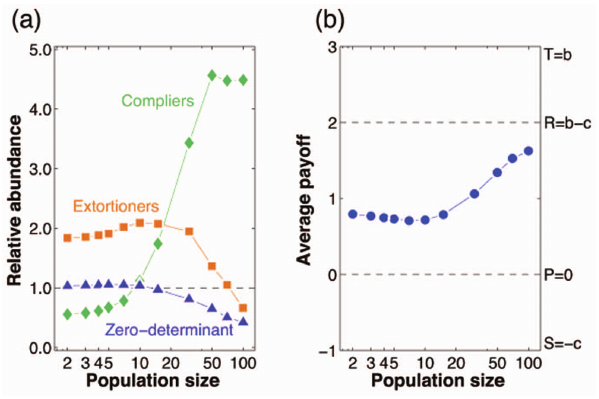
Figure 6. Statistics for the stochastic dynamics on the space of all memory-one strategies. Instead of taking the enforceable pairs ( l , s ) as the evolving traits, we consider the adaptive dynamics on the space of memory-one strategies p ~ ( p R , p S , p T , p P ) , see also [23,25]. (a) To assess the impact of zero-determinant strategies, extortioners, and compliers, we record how often the evolving population is in a d - neighborhood of these strategy sets, and compare this to their expected abundance in a neutral process. A given strategy set is thus favored by selection if its relative abundance exceeds one. Our simulations indicate that in small populations extortioners are favored by selection, whereas in large populations compliers are favored. (b) As a consequence, average payoffs increase with population size. Simulations are run for a sequence of 10 6 mutants. We assume that mutant strategies are uniformly distributed over the space of memory- one strategies, and use the parameters v ~ 1 and d ~ 0 : 1 . The other parameters of the evolutionary process are the same as in the previous figures.